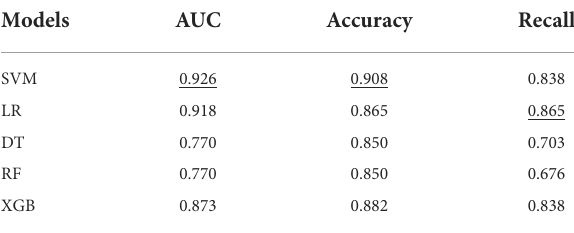
TABLE 3 Comparing the prediction performances of different models for